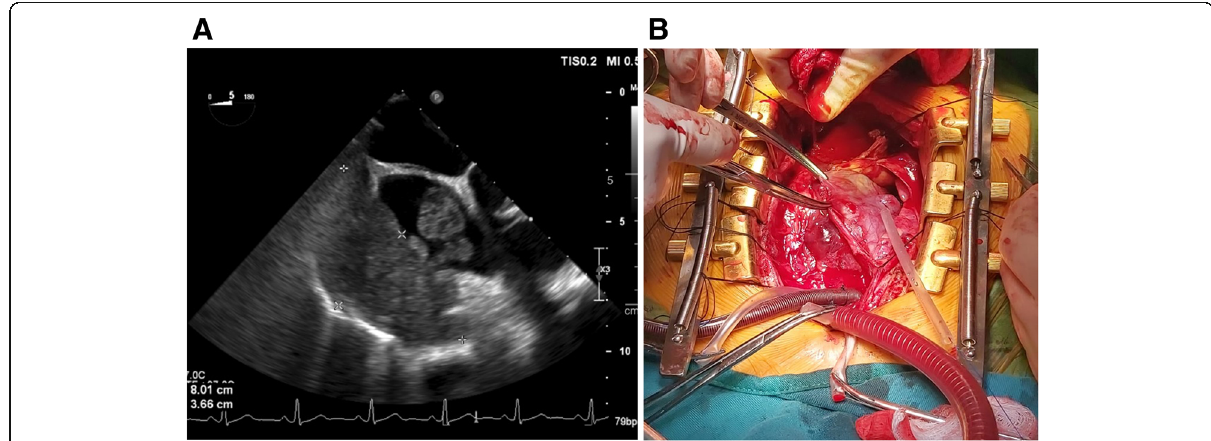
Fig. 2 a TEE showing a hyperechoic mass in the right atrium. b Cardiopulmonary bypass, pericardiotomy showing tumor